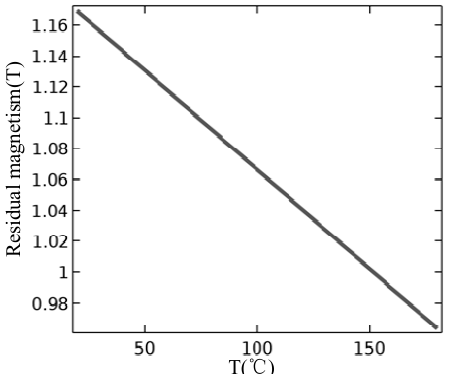
Figure 5. Permanent magnet (PM) remaining magnetism curve with temperature.